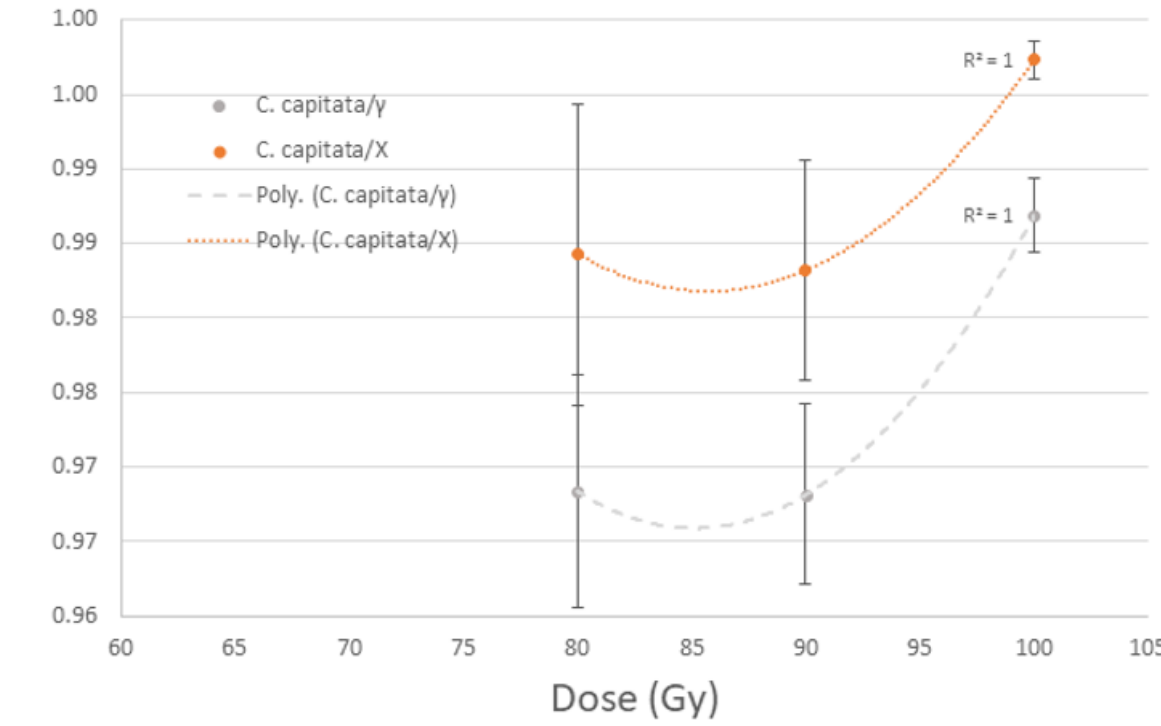
Figure 2. Dose responses of C. capitata following irradiation with 80, 90 and 100 Gy with X rays in an MK2 irradiator compared to γ -rays (Foss Model 812).